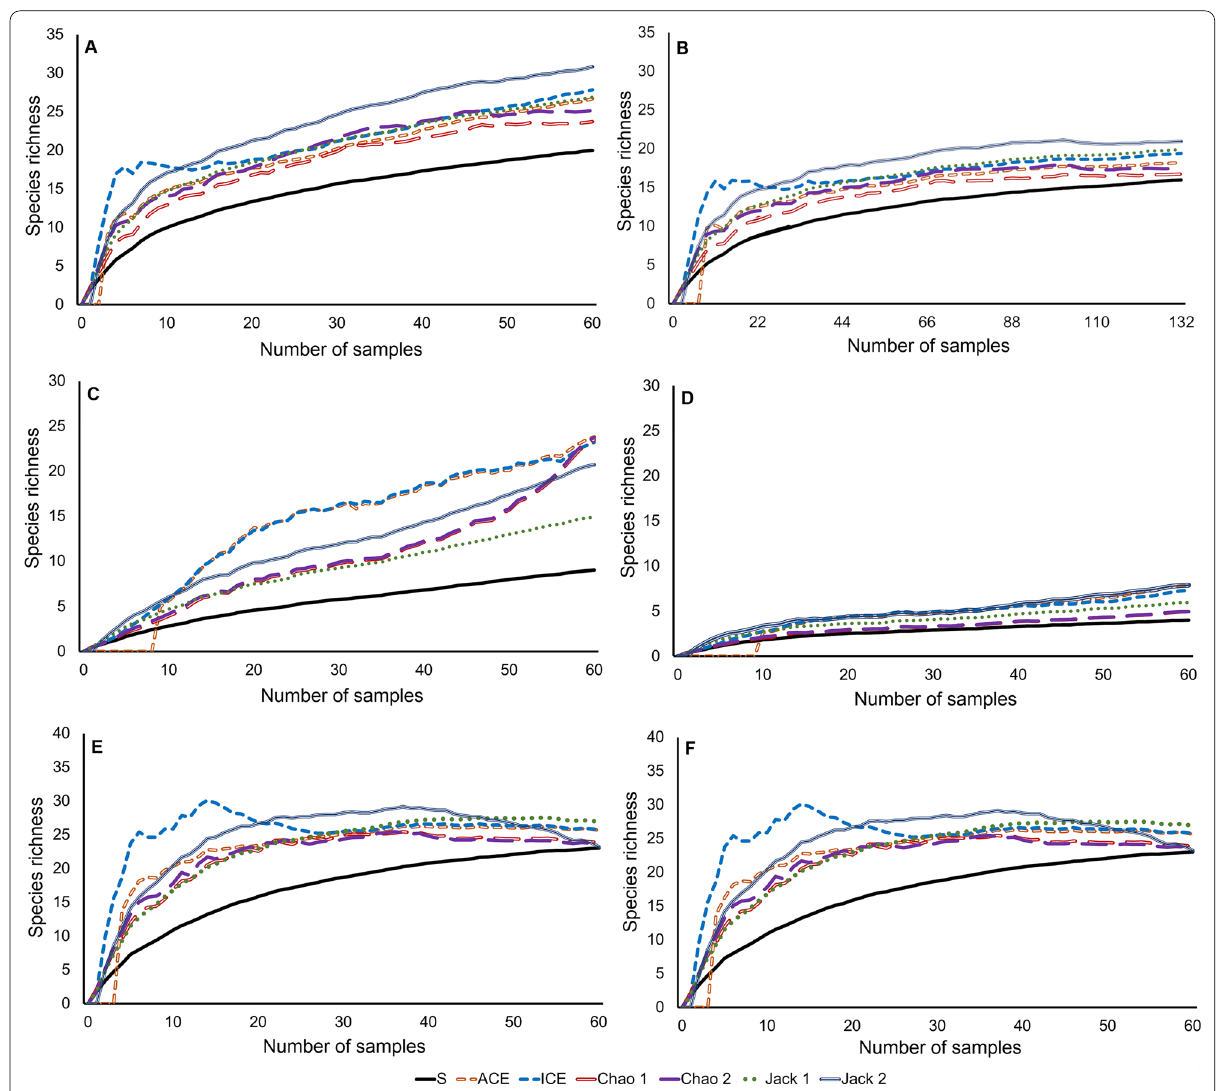
Fig. 4 Species richness estimation curves for semi-natural site 1, Chaco, Argentina, with adult grassland; A – C – E : analyses with HTS; B – D – F : analyses without